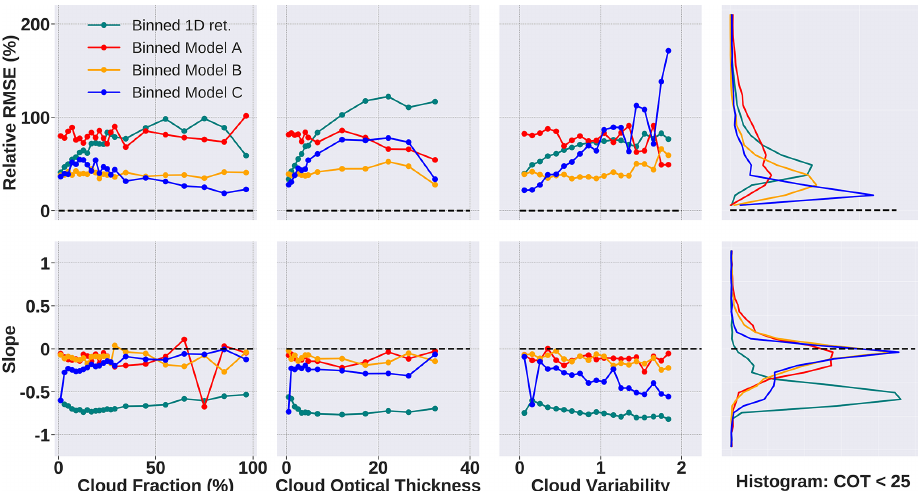
Figure 7. Comparison of models A, B, and C (red, orange, and blue lines, respectively) with IPA or 1D retrieval (shown in teal) obtained by methods described in Table 1. Model A is trained on scenes that have no coarsening factors applied (1 × 1), B is trained on scenes coarsened by a factor of 2 × 2, and C is trained on scenes coarsened by a factor of 4 × 4. The dashed black line depicts the ideal retrieval. All models are being evaluated against a pool of unseen images with 1 × 1, 2 × 2, and 4 × 4 coarsening factors. The rightmost column shows the histogram samples that have COT < 25.